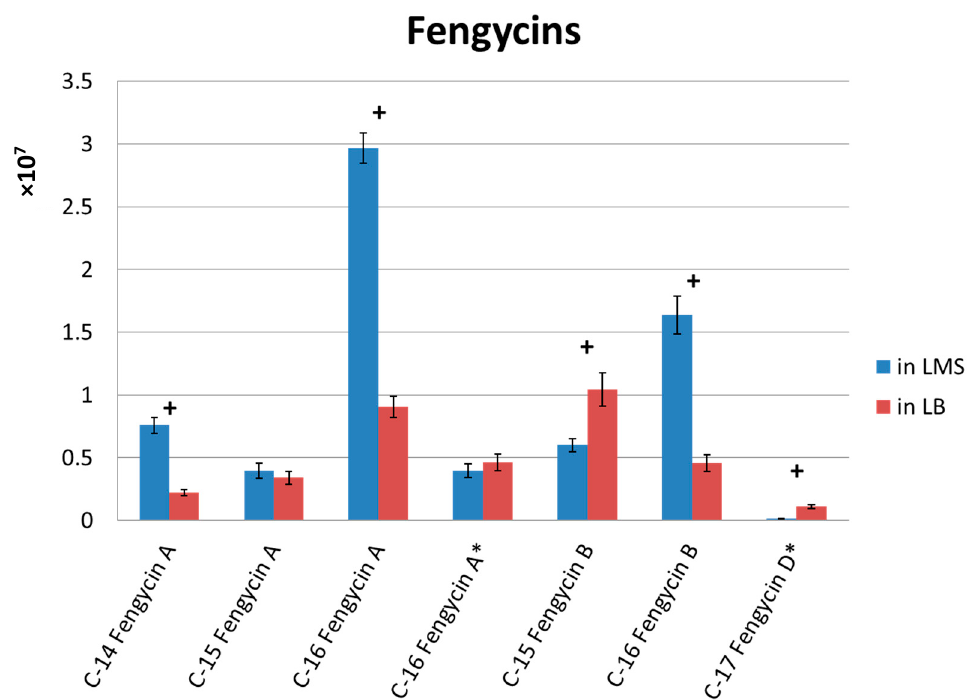
Figure 4. Quantification of fengycins in Ba-BPD1 cultured in LMS and LB media. * Linear form of lipopeptides; + significant difference with a p -value < 0.005 (all data were analyzed by two sample t -tests). Each experiment was conducted three times and expressed as the mean ± standard deviation.